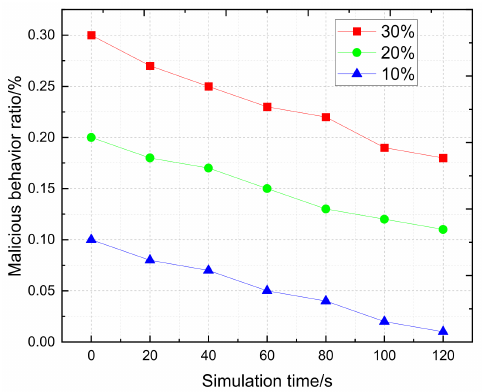
Figure 5. Comparison of the proportion of malicious